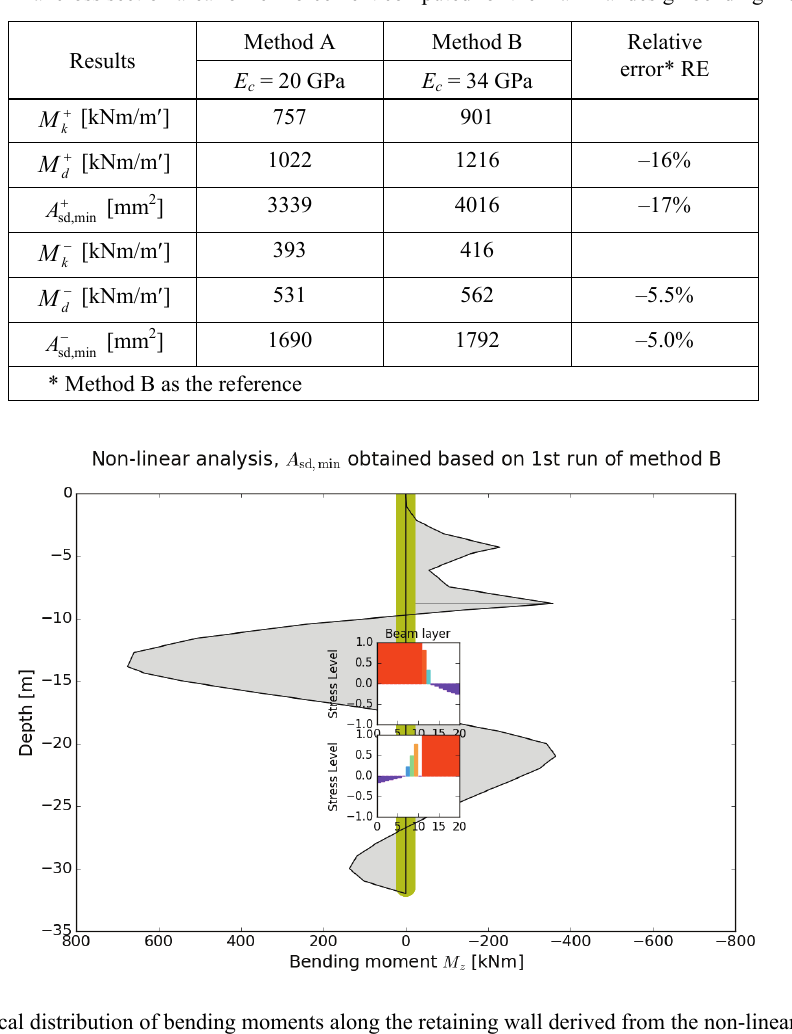
Fig. 8. Critical distribution of bending moments along the retaining wall derived from the non-linear analysis for the retaining structure (2nd run of Method B), and the corresponding distributions of stress levels in the non-linear layers in beam elements for two selected cross sections at the location of the maximal bending moments M max from the inward and outward sides, respectively. Red bars stand for tension with 1.0 representing full strength mobilization, and blue bars meaning